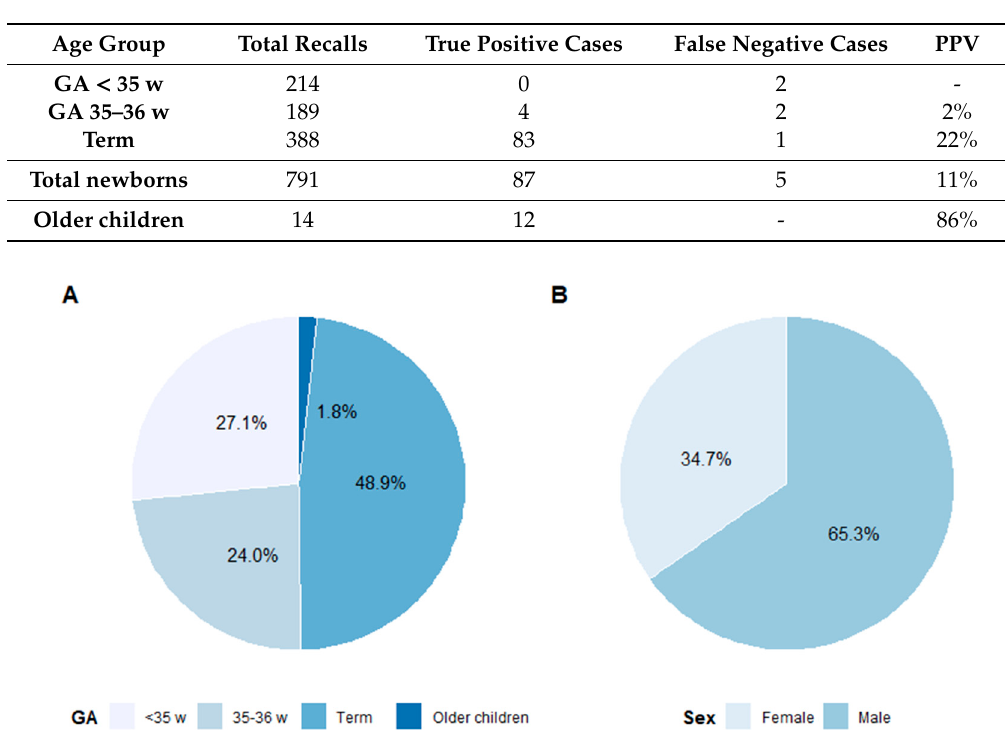
Table 1. All recalls, true positive cases, false negative cases and PPV values for the CAH screening in Sweden of more than one million children between 2011 and 2019.